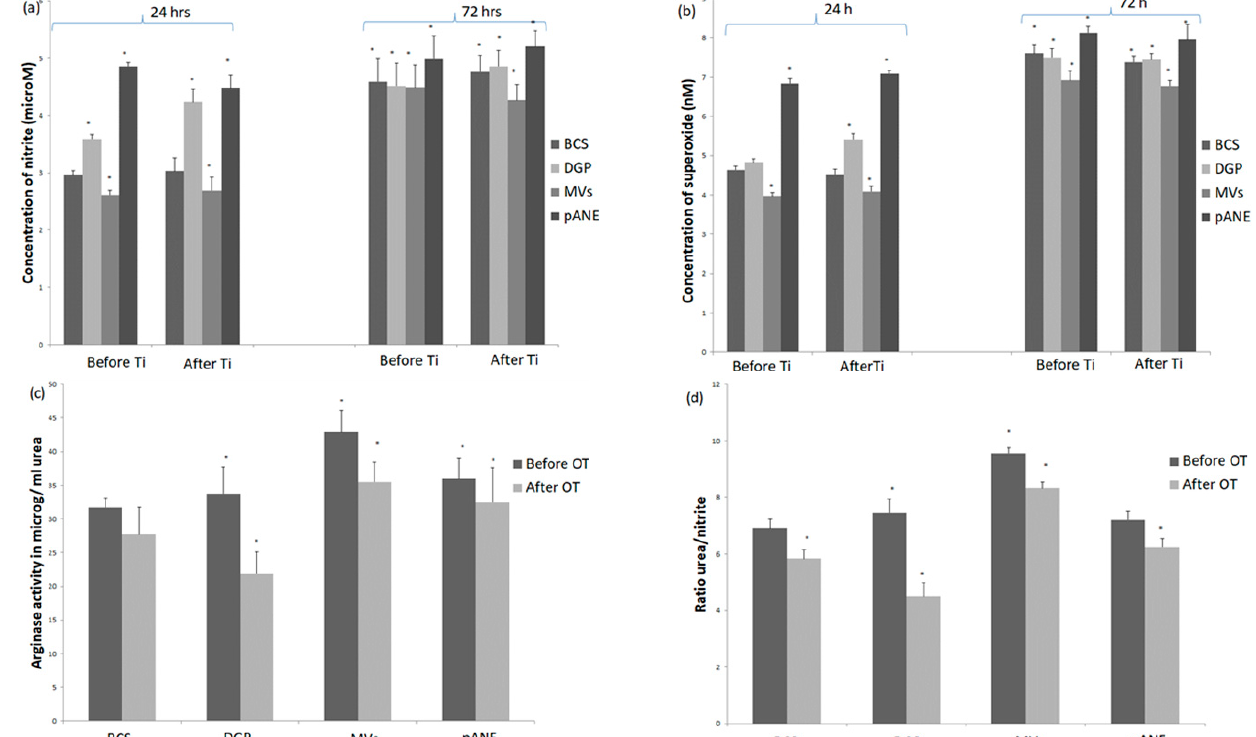
Figure 4. Generation of ( a ) nitric oxide, ( b ) superoxide and ( c ) arginase activity with ( d ) ratio urea/nitrite in MDMs from sheep ( n = 8) 7 days before and 2 h after Ti implant insertion into the tibia. Cultures stimulated only with DMEM with 10% BCS and stimulated with neutrophil degranulation products (DGP), or neutrophil-derived microvesicles (MVs) or porcine antimicrobial neutrophil extract (pANE) for 24 h and for 72 h shown in the Figure 4a,b. Data present mean values ± SE of at least three replicates for each bar at both time points. * p < 0.05 values differ significantly compared with BCS after 24 h incubation ( a , b ). Arginase activity ( c ) and ratio urea/nitrite ( d ) in lysates of MDMs cultures stimulated with BCS, DGP, MVs or pANE. Data present mean values ± SE of at least three replicates for each bar. * p < 0.05 values differ significantly compared with BCS ( c , d ).